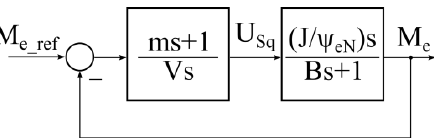
Figure 7. Schematic diagram of the electromagnetic torque control system of the simplified motor.